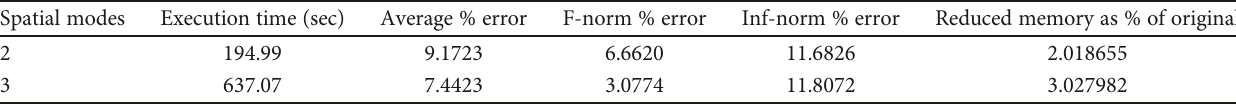
Table 13: Densities of 3D reduced model built from all ∣ z ∣ = 56 2D reduced models.